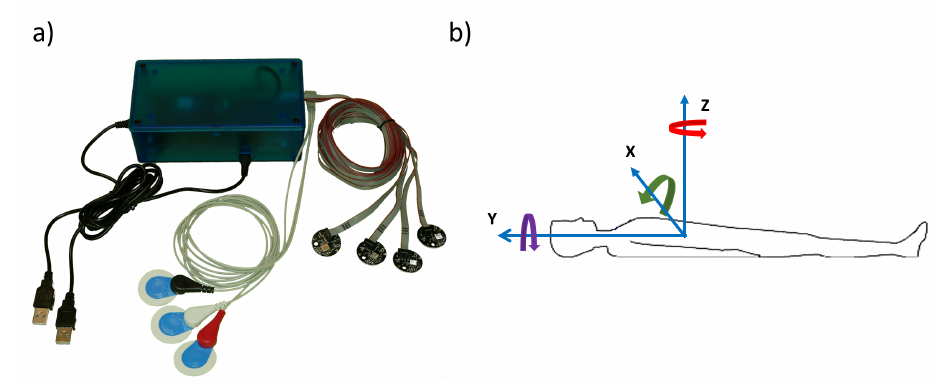
Figure 1. The motion measurement system (MMS) and the directions of measurement axes. Inset ( a ): the novel multinodal measurement system, which consists of four MEMS-based motion measurement nodes and three ECG electrodes. Inset ( b ): directions of the measurement axes with respect to the measured